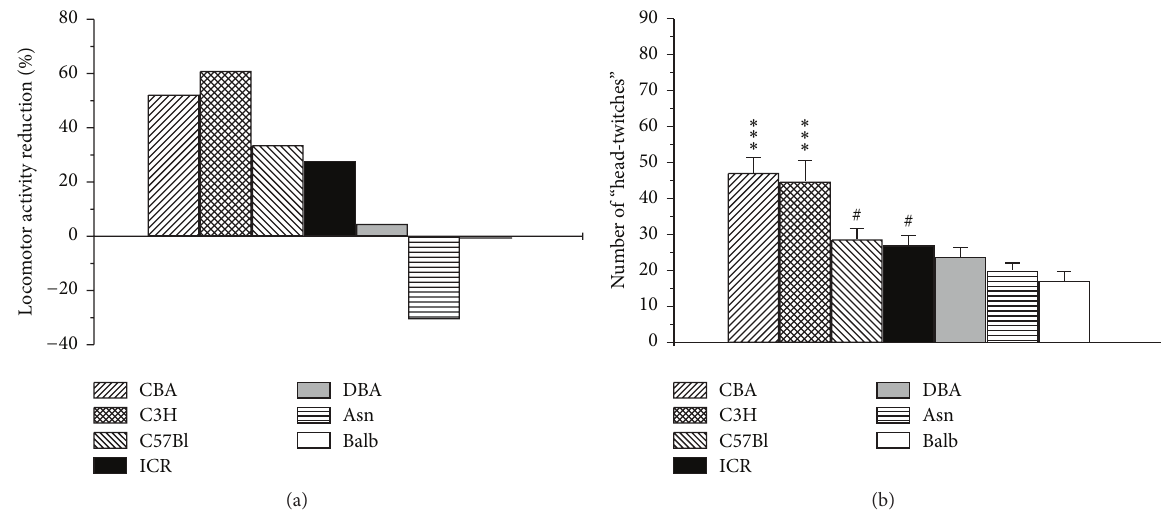
Figure4:Functionalactivityof5-HT 2 A and5-HT 2 C receptorsinseveninbredmousestrains.(a)Theefficiencyoflocomotoractivityreduction was calculated as the ratio (%) of the difference between the mean distance traveled by mice treated with saline and the mean distance traveled by mice treated with MK-212 related to the mean distance traveled by saline group. (b) Functional activity of 5-HT 2 A receptor was estimated by number of 5-HT 2 A receptor-mediated head-twitches induced by 5-HT 2 A agonist DOI (1mg/kg, i.p.). The data are presented as mean ± SEM ( 𝑛 = 8 per group; ∗∗∗ 𝑝 < 0.001 compared with C57Bl/6, ICR, DBA/2J, Asn, and Balb/c strains; # 𝑝 < 0.05 compared with Balb/c strain).